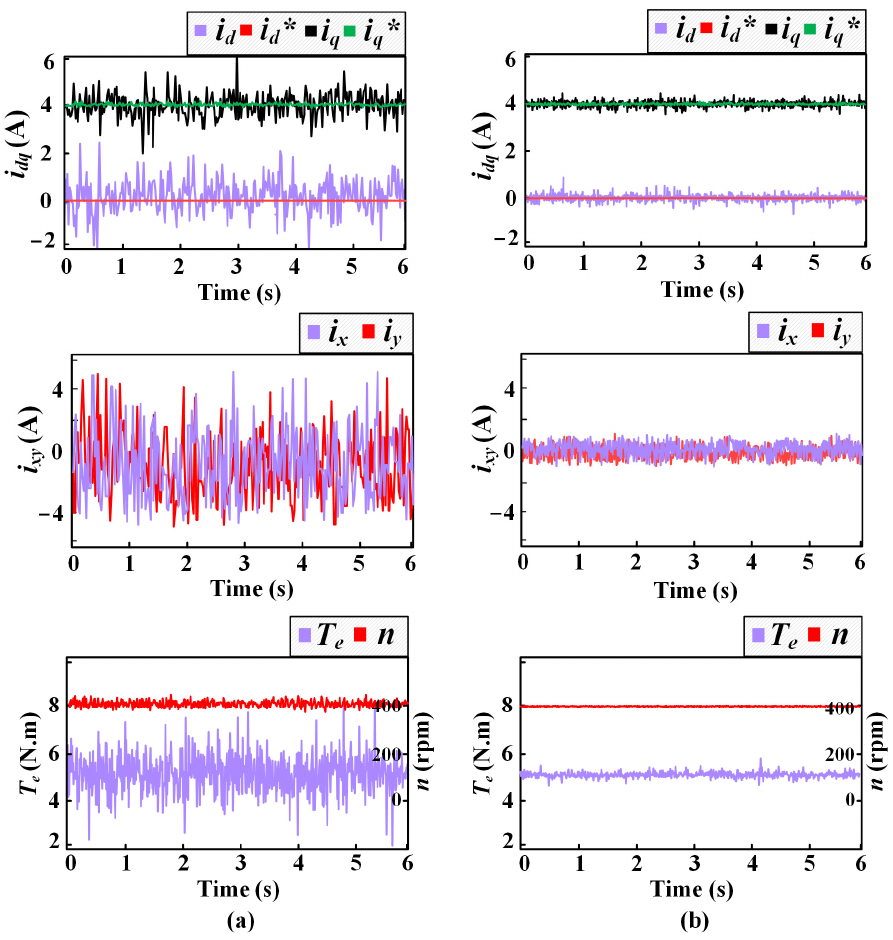
Figure 13. Test 1 for both methods in steady-state with 5 N.m load. ( a ) Conventional VV-MPC; ( b ) proposed MVV-MPC. ( b ) proposed